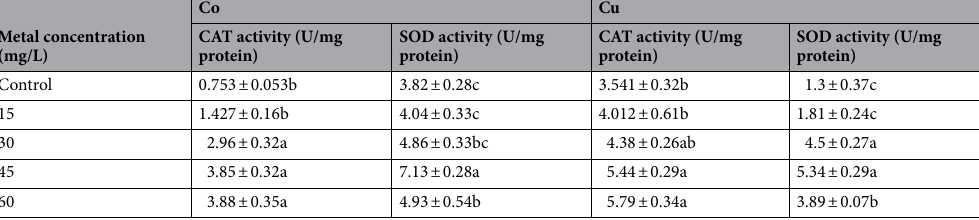
Table 5. Comparison of the average enzymes activity (U/mg protein) of Pleurotus sp . mycelia grown in MMN medium containing heavy metals based on Duncan’s test. Treatments with the same letters are not statistically